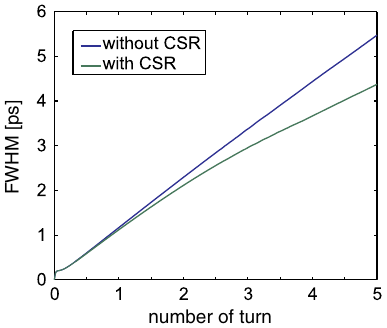
FIG. 15. Simulated FWHM of the central dip in the charge density distribution without (blue curves) and with (green curves) CSR losses as a function of the number of